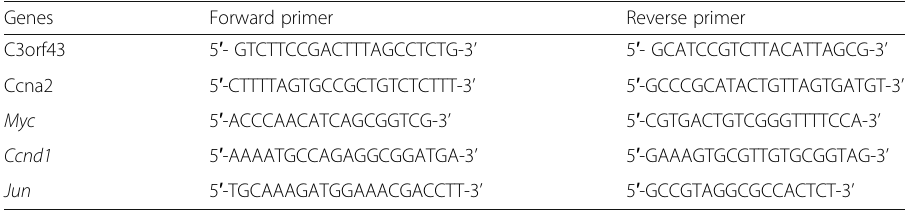
Table 2 The primer sequences used in the RT-PCR